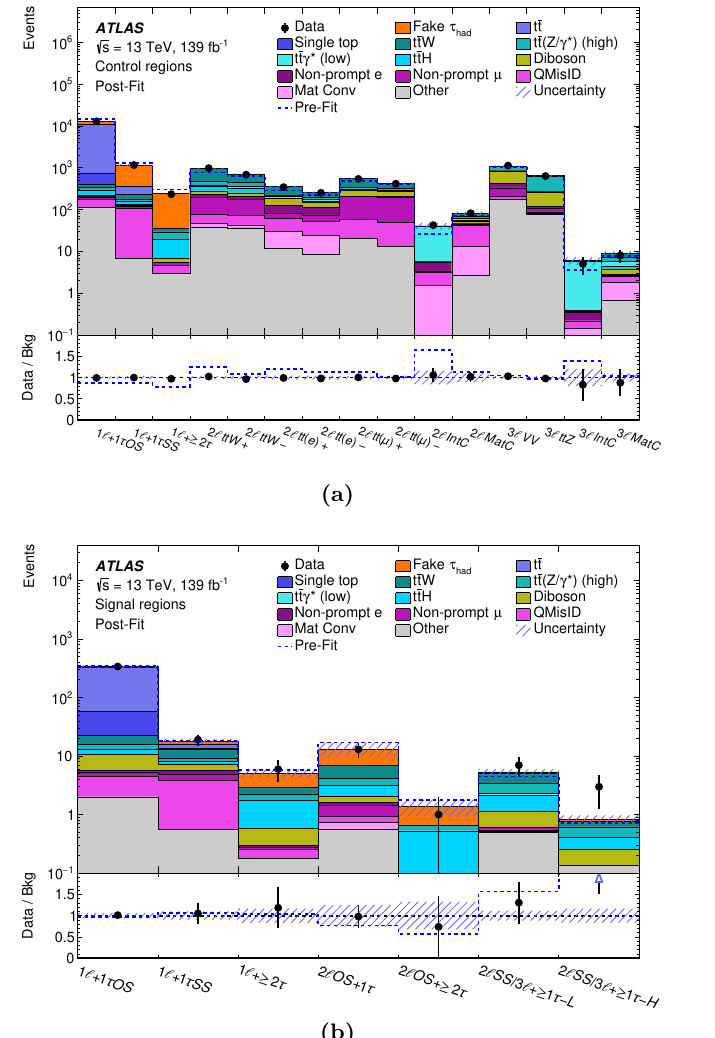
Figure 10. Comparison between data and the background prediction for the event yields in (a) the 15 control region categories and (b) the 7 signal region categories. The background contributions after the likelihood fit to data (“Post-Fit”) under the background-only hypothesis are shown as filled histograms. The total background prediction before the likelihood fit to data (“Pre-Fit”) is shown as a dashed blue histogram in the upper panel. The ratio of the data to the background (“Bkg”) prediction is shown in the lower panel, separately for post-fit background (black points) and pre-fit background (dashed blue line). The size of the combined statistical and systematic uncertainty in the background prediction is indicated by the blue hatched band. The blue triangles indicate points that are outside the vertical range of the